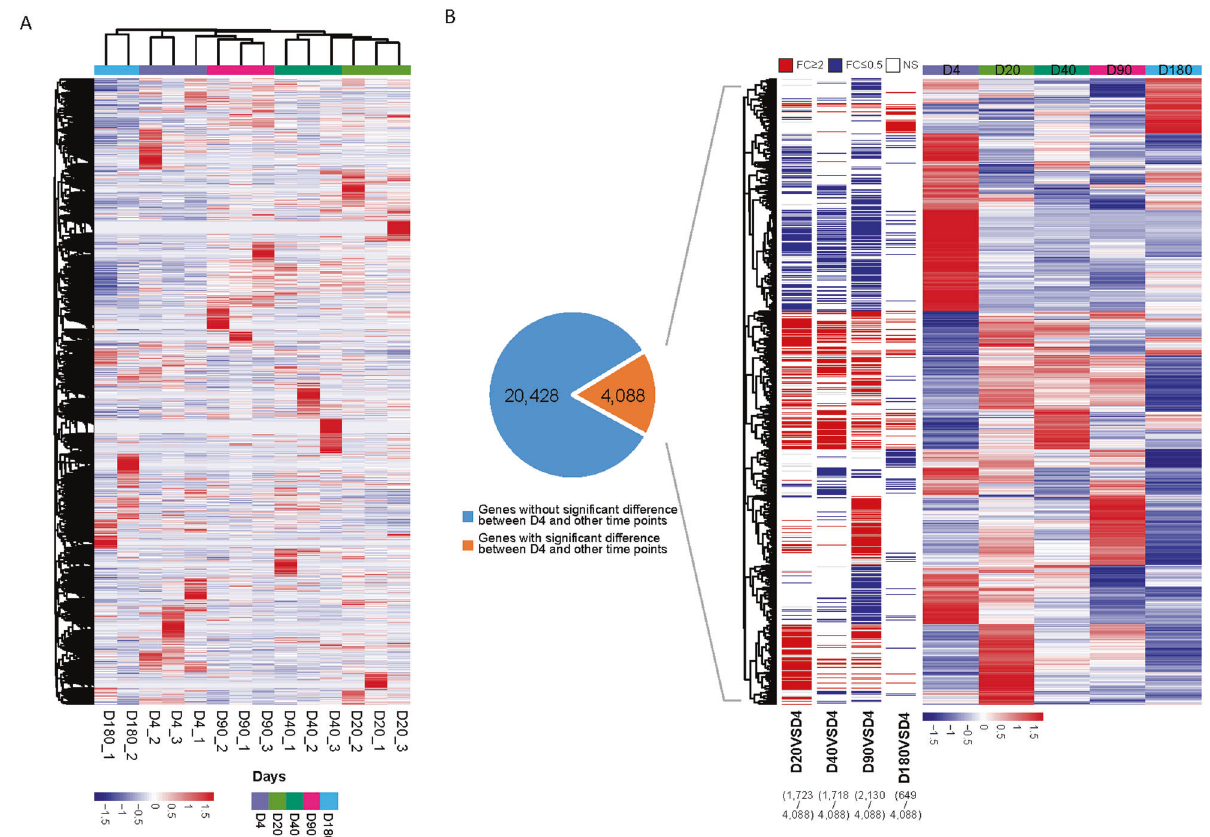
Fig. 3 Gene expression analysis in MaSCs by RNA-seq. A Heatmap of 15,232 genes whose TPM values dynamically changing over the time points with standard deviation > 0.5. Hierarchical clustering algorithm was used to group samples on the basis of the expression pattern. B Pie chart illustrates numerical proportion of genes with or without signi fi cantly differential expression between D4 and other time points. Genes with adjusted P -value < 0.05 and fold change (FC) ≥ 2 were de fi ned as statistically differential expression. Four thousand eighty-eight differentially expressed genes were represented in the